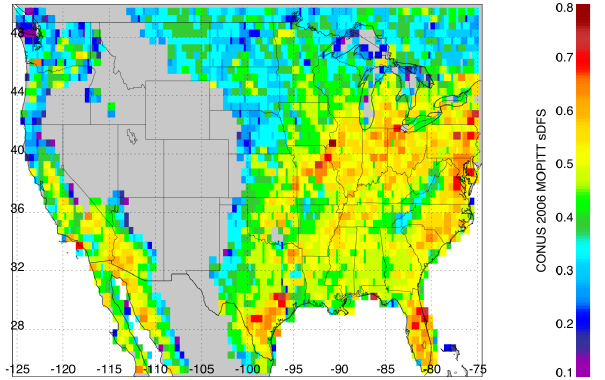
Figure 1. MOPITT V5J sensitivity to near surface CO, given by the trace of the AK for the lowest 3 layers, in 0.5°x0.5° bins. Only land scenes with surface pressure > 900 hPa are included, with higher altitudes, water and missing data indicated by grey or white.